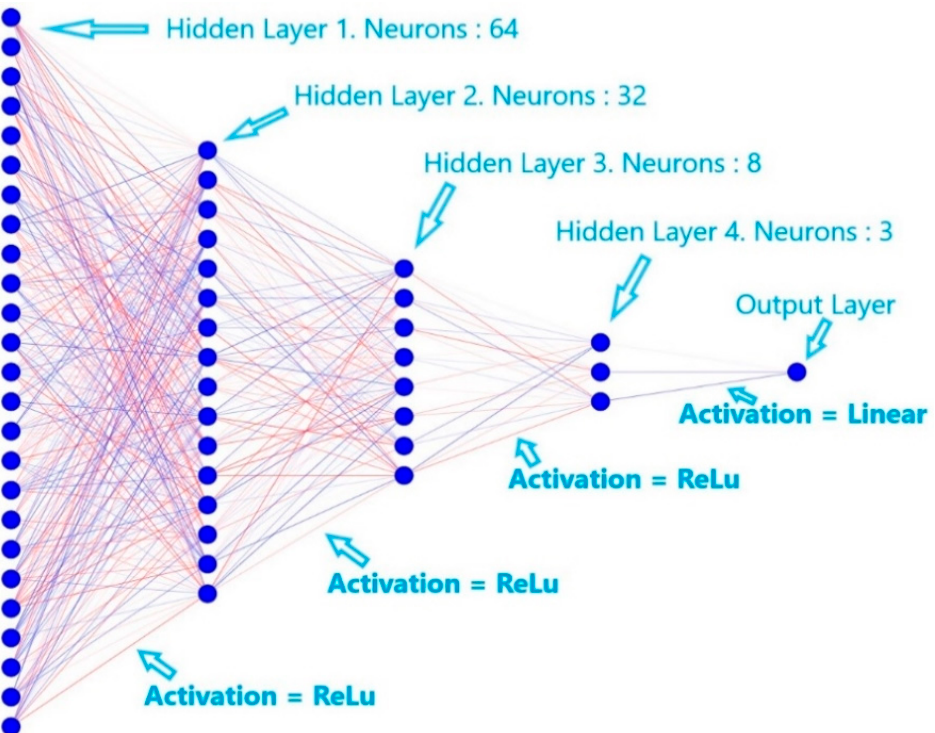
Figure 6. The graphical structure of the deep reinforcement learning (DRL) Application Neural Model.